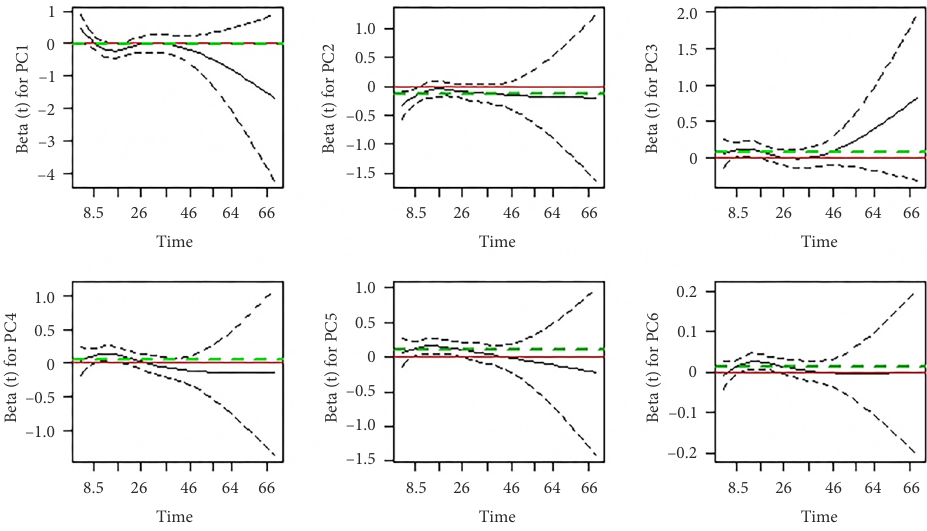
Figure 6. Time-dependent coefficients for PCs of macroeconomic variables of Cox PH